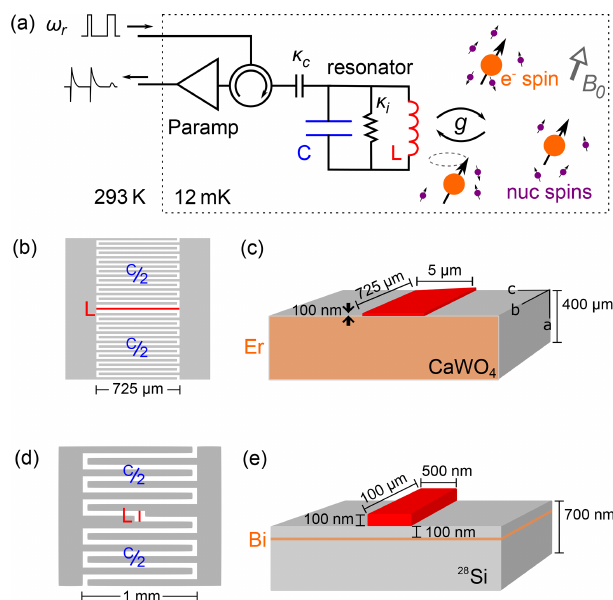
Figure 5. Experimental setup and samples. (a) Schematic of the low-temperature EPR spectrometer. The LC resonator is inductively coupled to electron spins, which are coupled to a nuclear-spin bath that causes the ESEEM. The spins are probed by sequences of mi- √ LC. Reflected crowave pulses at the resonator frequency ω r = 1 / pulses as well as the echo signal are routed to a parametric ampli- fier, further amplified at 4K, and finally demodulated and digitized at room temperature. (b, c) Design of the LC resonator used for the detection of erbium ion spins, with a 725µm long, 5µm wide induc- tor. It is patterned out of a 100nm thick niobium film deposited on top of a CaWO 4 substrate bulk doped with Er 3 + ions. (d, e) Design of the LC resonator used for the detection of bismuth donor spins, with a 100µm long, 0.5µm wide inductor. It is patterned out of a 100nm thick aluminum film deposited on top of a silicon substrate isotopically enriched in 28 Si, in which bismuth ions were implanted at a 50–100nm